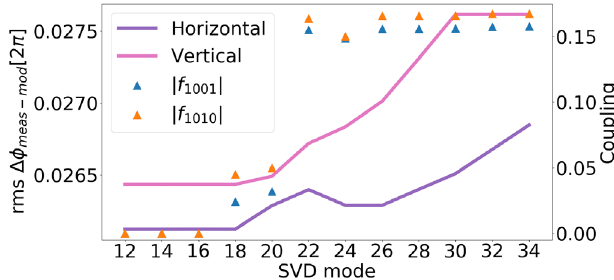
FIG. 11. Trade-off between correct computation of the expected coupling at the location of introduced skew quadrupole field error and increase of the noise in the measured phase advance errors Δ ϕ defined as rms between measured and model phase meas-mod advances. The right scale shows the computed values of f 1001 and f 1010 depending on the number of SVD modes used in SVD